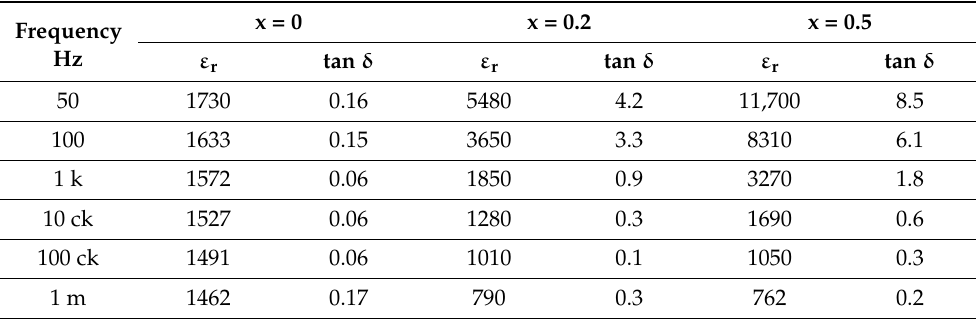
Table 4. Dielectric constant and loss of CCTO and Erbium dopants using microwave sintering at 1000 ◦ C for 10min